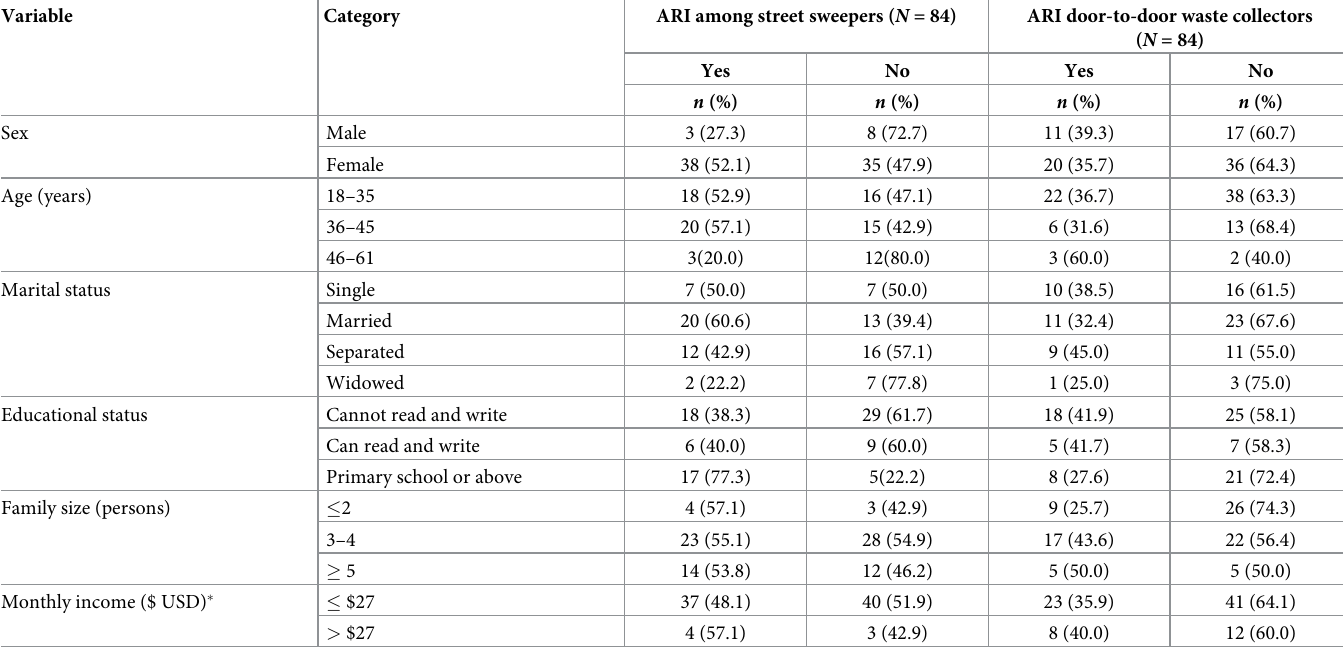
Table 1. Socio-demographic characteristics among street sweepers and door-to-door waste collectors in Dessie City, Ethiopia, March to May 2018.